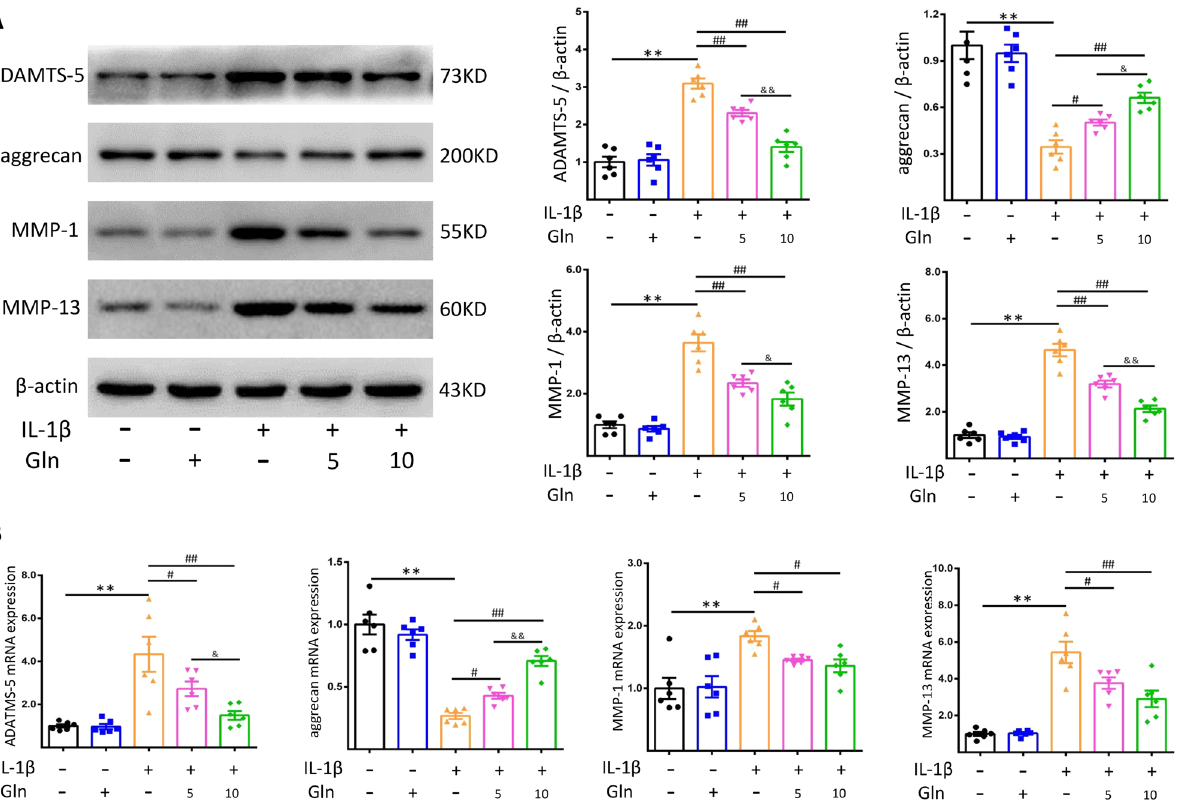
Figure 3. Effect of both concentrations of glutamine on ADAMTS-5, aggrecan, MMP-1, and MMP-13 in chondrocytes treated with IL-1β. Glutamine promoted the expression of a protective protein (aggrecan) and inhibited the expression of harmful proteins (ADAMTS-5, MMP-1, MMP-13). The benefit of the high concentration group was better than that of the low concentration group. ( A ) The protein expression was examined by western blot with β-actin as the internal standard. ( B ) mRNA expression levels were checked using qRT-PCR. All data are presented as the M ± SEM (n = 6 in each group). *p < 0.05 vs. IL-1β(−) and Gln(−) group, **p < 0.01 vs. IL-1β(−) and Gln(−) group; # p < 0.05 vs. IL-1β(+) and Gln(−) group, ## p < 0.01 vs. IL-1β(+) and Gln(−) group; & p < 0.05 vs. IL-1β(+) and Gln(5) group, && p < 0.01 vs. IL-1β(+) and Gln(5) group by ANOVA.